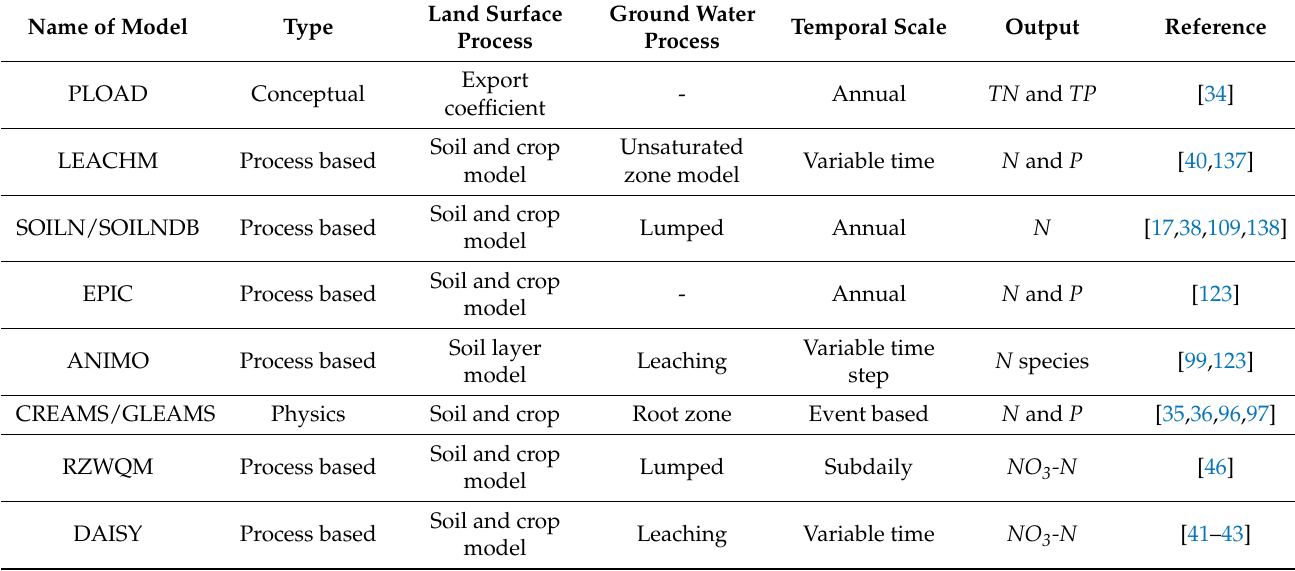
Table A1. The summary of plot-scale models.